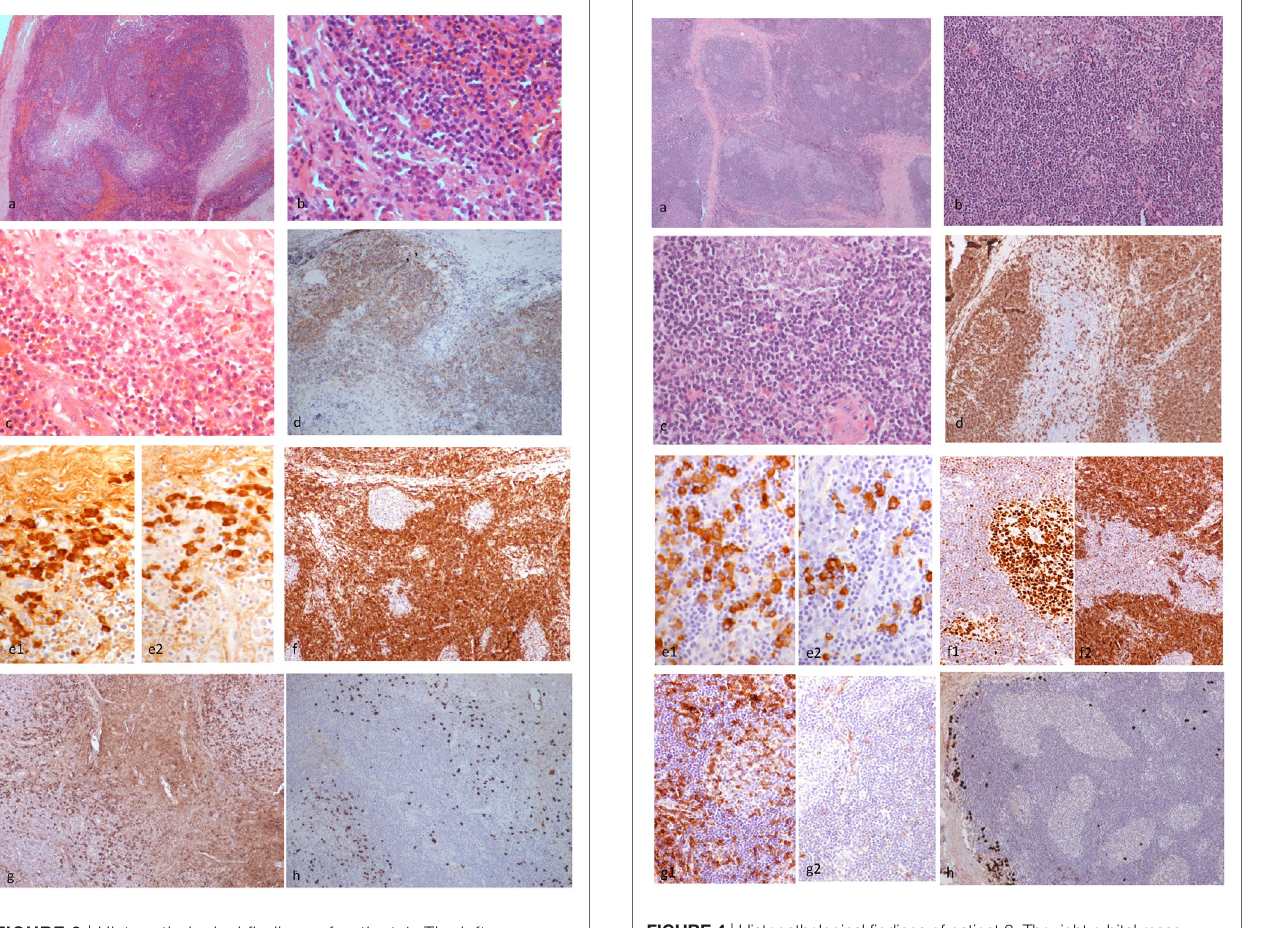
FIGURe 3 | Histopathological findings of patient 1. The left upper eyelid mass showed cellular lymphoid nodules separated by dense hyalinized fibrous septa (H&E × 4) (a) . The nodules were composed of hyperplastic lymphoid follicles surrounded by well formed mantle zone and the septa contains mature plasma cells (H&E × 40) (B) . Mature plasma cells were shown in another area of the septa (H&E × 40) (C) . CD20 monoclonal antibody staining revealed that the B cells were confined within the follicles ( × 10) (D) . The plasma cells are polytypic for kappa (e1) and lambda (e2) light chain ( × 10). BCL2 antibody staining revealed the absence of BCL2 in the germinal centers (F) . Many of the plasma cells are positive for IgG (G) and a fair amount are positive for IgG4 (H) ( × 10), but the IgG4:IgG ratio is less than